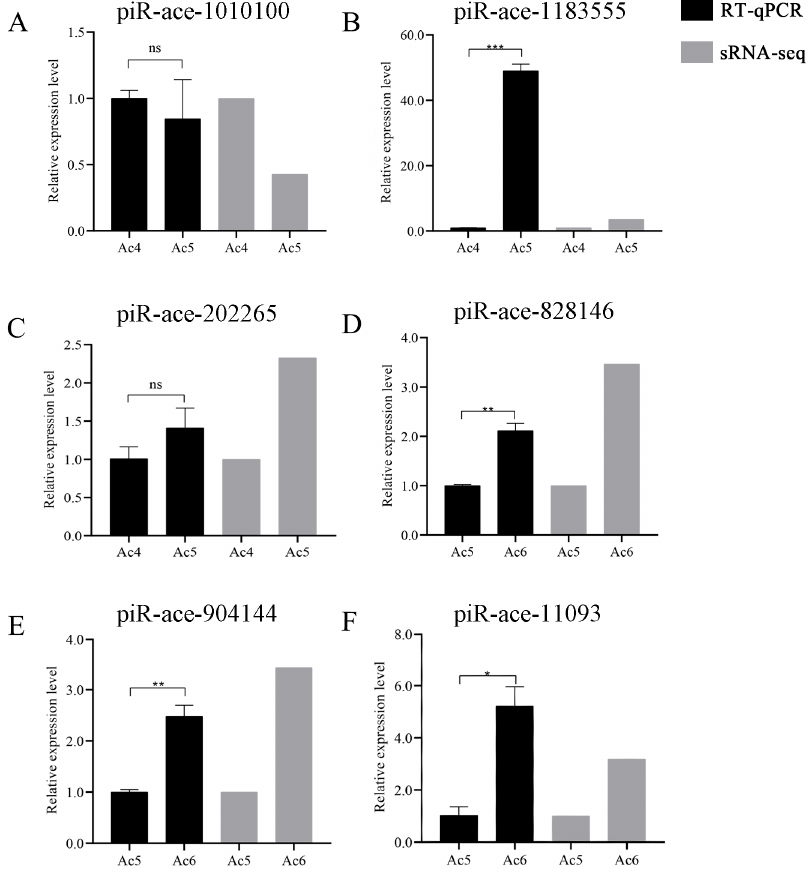
Figure 8. RT-qPCR verification of six A. c. cerana DEpiRNAs. ( A – C ) Relative expression levels of piRNAs from the Ac4 vs. Ac5 comparison group. ( D – F ) Relative expression level of piRNA from the Ac5 vs. Ac6 comparison group. ns indicates non-significant, * indicates p < 0.05, ** indicates p < 0.01 and *** indicates p < 0.001.